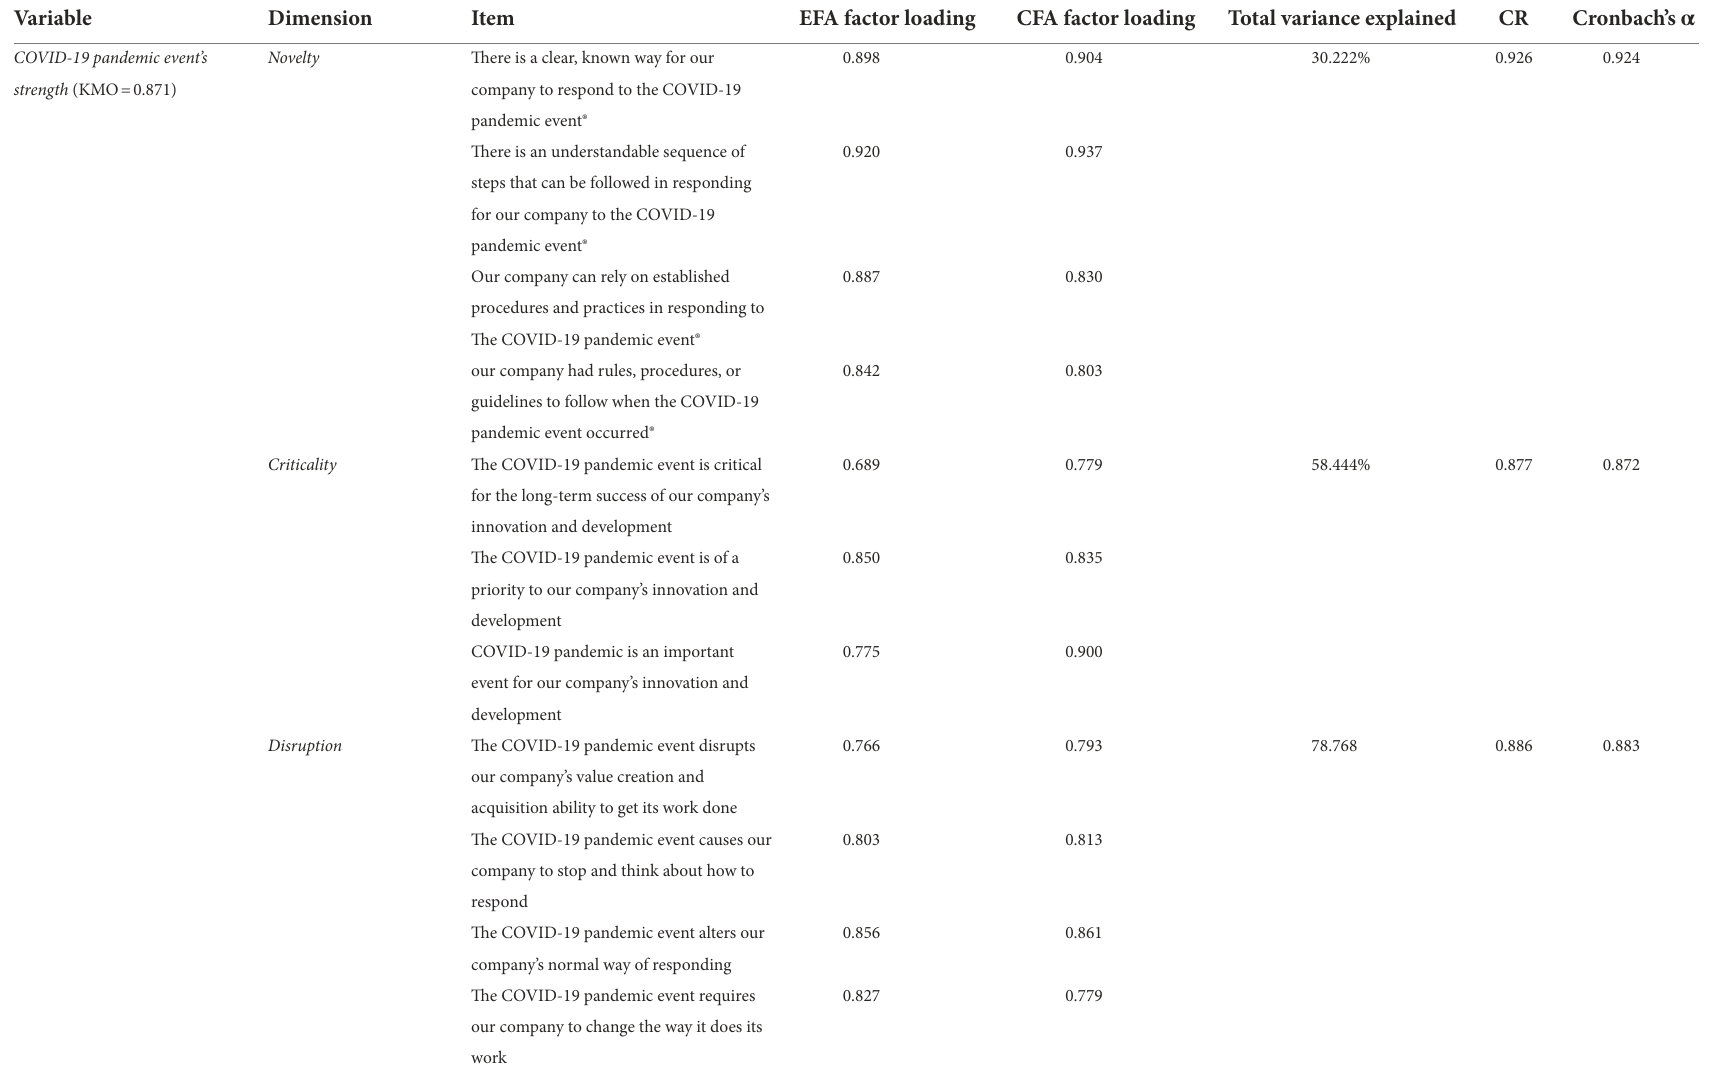
TABLE 2 Measurement items and the reliability and validity of variables. Variable Dimension Item EFA factor loading Total variance explained CR COVID-19 pandemic event’s strength (KMO =